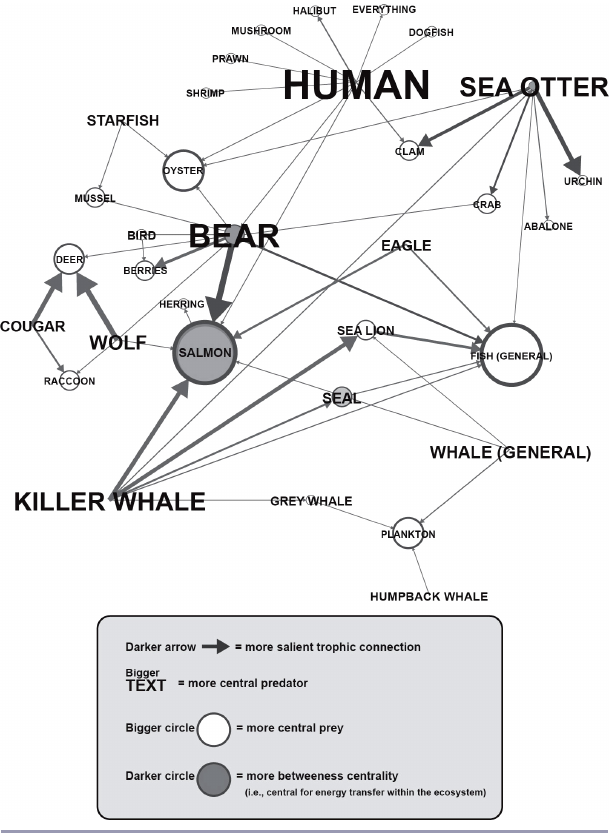
Fig. 1 . Aggregate mental model of the regional food web: local residents. The size of a species’ name in a given group’s aggregate mental model corresponds to that species’ out-degree centrality, the size of a species’ circle corresponds to its in- degree centrality, and the darkness of a species’ circle corresponds to its betweenness centrality. Finally, the width of an arrow corresponds to that given trophic relationship’s average cognitive accessibility. From this visualization, it thus appears that local residents’ average conception of the Clayoquot Sound food web revolves largely around the feeding habits of large charismatic megafauna (bears, killer whales, wolves, and cougars), as well as that of sea otters. Local residents appear aware of humans’ role as a prolific predator in the system, but this role is far less salient, or immediately apparent, to them than the behavior of other predatory mammals. Salmon, as a taxonomic class, appear to occupy a uniquely central role in local residents’ conceptions of the social-ecological system, both as a crucial “species” for energy transfer throughout the food web, as well as a “species” that is fed on (along with fish in general) by the widest diversity of